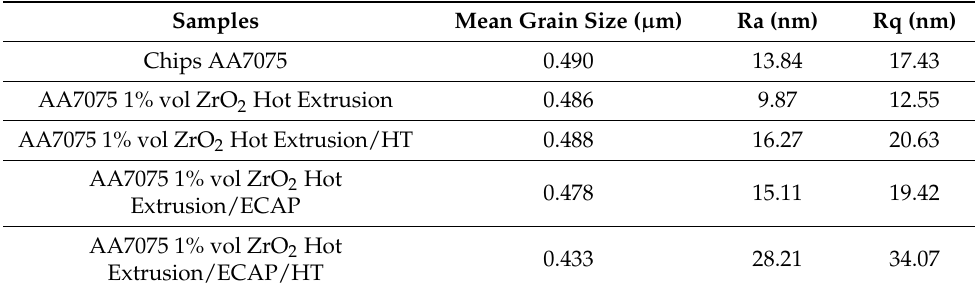
Table 12. AFM mean grain size and surfaces